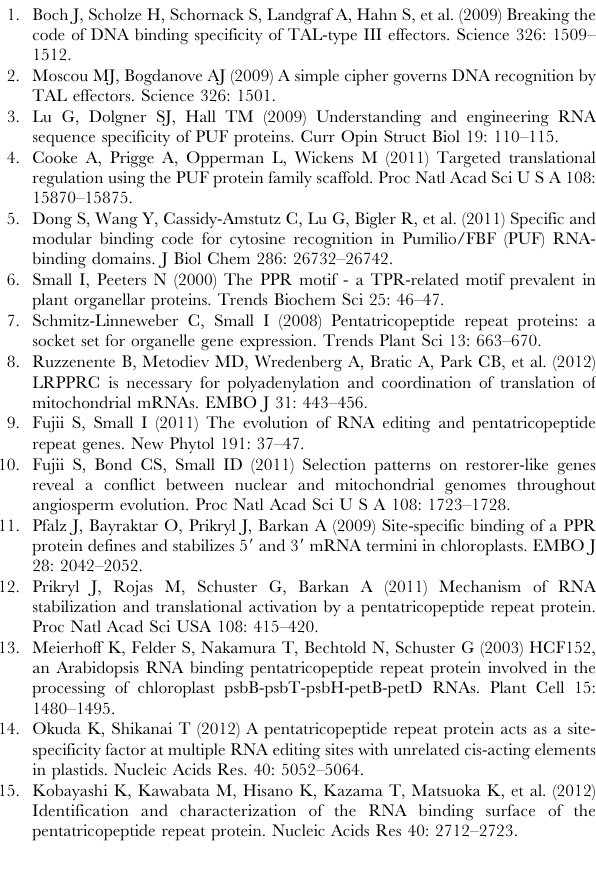
Table S3 Correlations between amino acids at positions 6, 1 9 and aligned nucleotides. The tables show frequencies of co- occurrence of amino acids and nucleotides from the alignments in Figure 2 and Figure S1. A. P motifs, positions 6, 1 9 versus each nucleotide. B. S motifs, positions 6, 1 9 versus each nucleotide. C. P motifs, position 6 versus purines (R), pyrimidines (Y). D. S motifs, position 6 versus purines (R), pyrimidines (Y). P-values were calculated using G-tests. P-values in A and B are for the most positively correlated nucleotide. Significance was evaluated at 5% allowing for multiple testing (using the Sˇida´k correction). Green shading indicates significantly correlated, magenta shading indicates significantly anti-correlated.